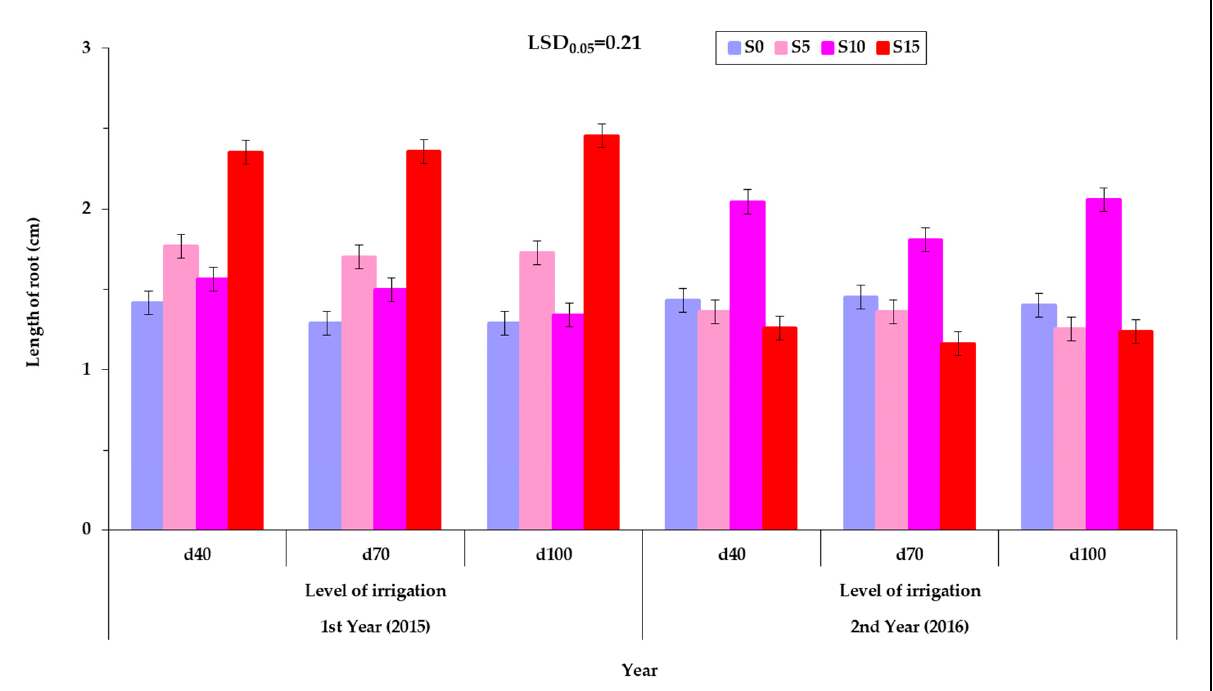
Figure 7. Root length at the three levels of irrigation (d 40 , d 70 and d 100 ), at the four PEG concentrations (S 0 , S 5 , S 10 and S 15 ), at the two years of experimentation. Data presented are estimated mean values averaged over the five cultivars. LSD is the least significant difference at the 0.05 significance level. Error bars correspond to the estimated common standard error of the mean values. Each mean value has been estimated utilizing n = 20 measurements. Figure S7 (see Supplementary Material) presents the observed mean values and the corresponding individual standard errors.